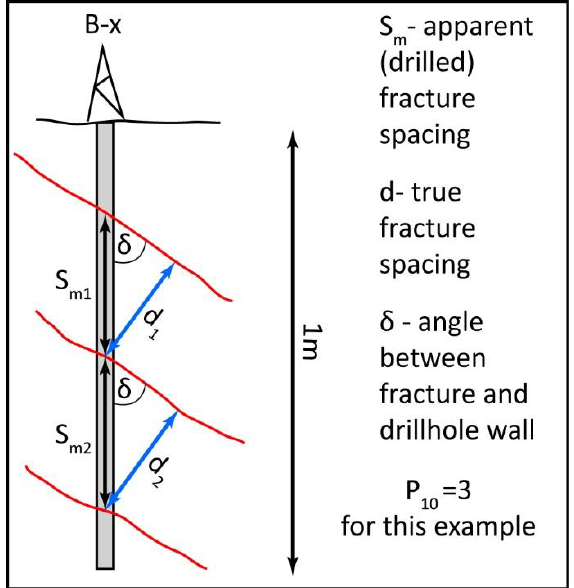
Figure 7. The relation between apparent (drilled) and true fracture spacing.